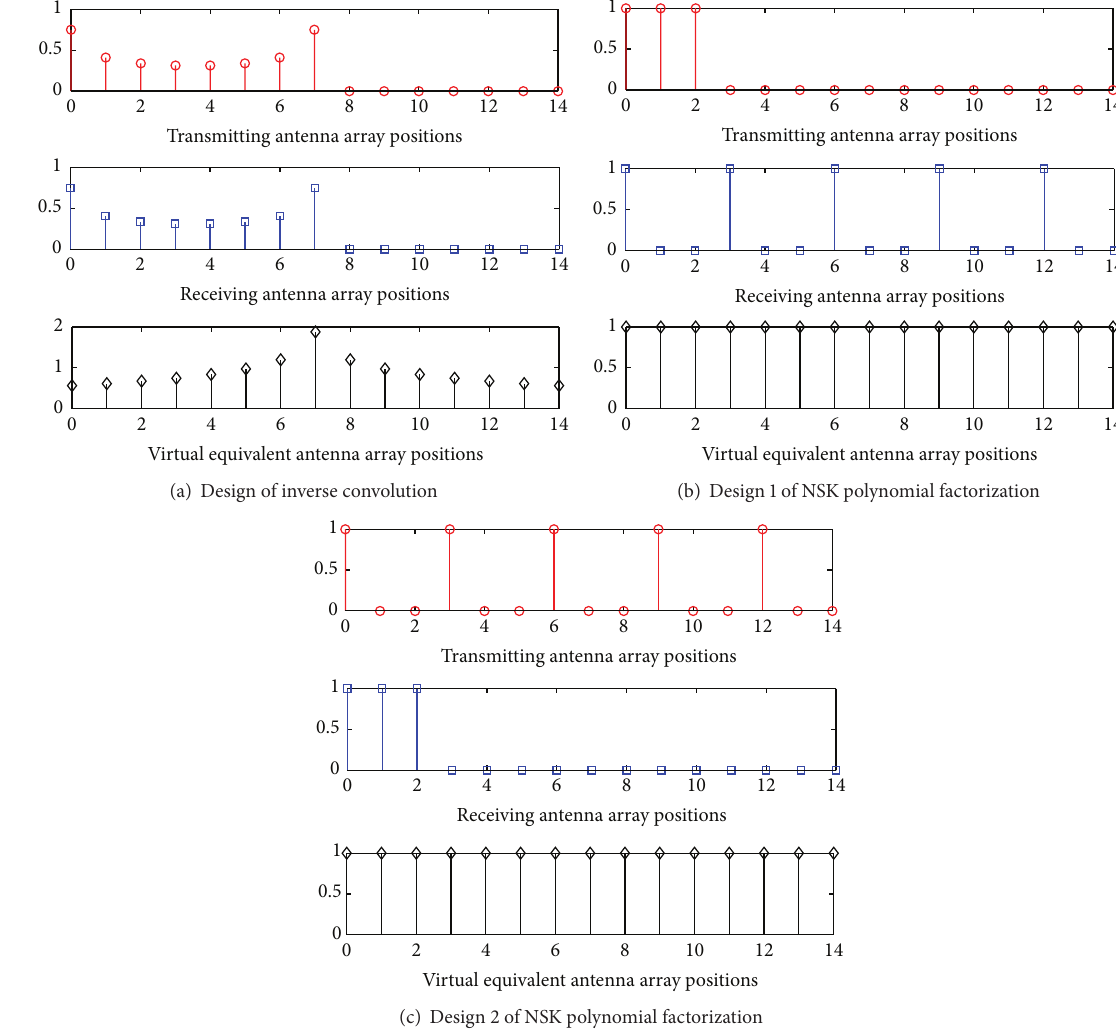
Figure 5: Design of inverse convolution and NSK polynomial factorization.